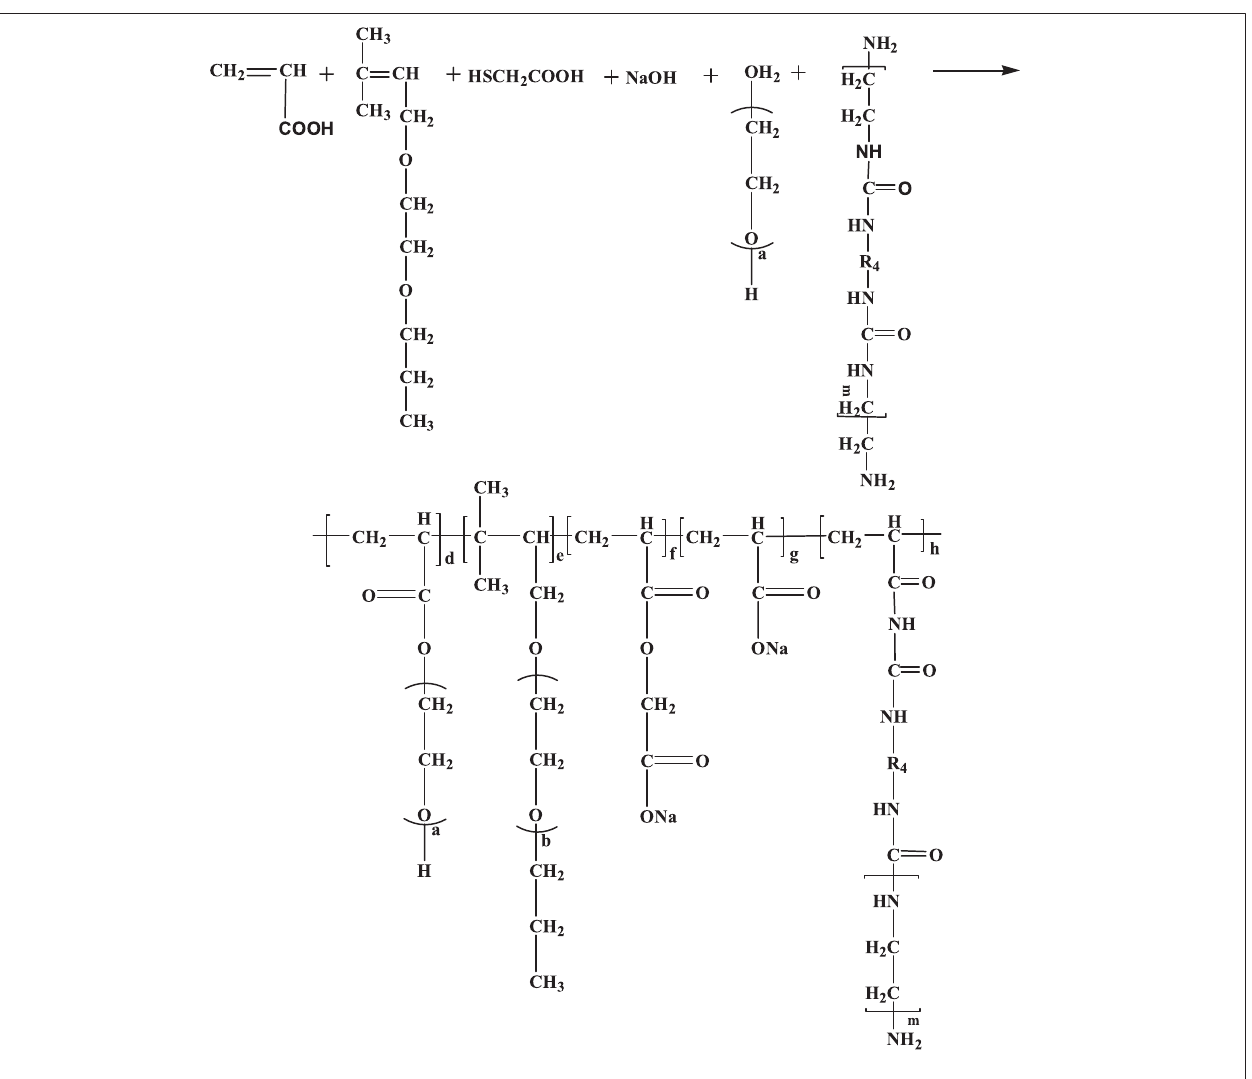
Frontiers in Materials |